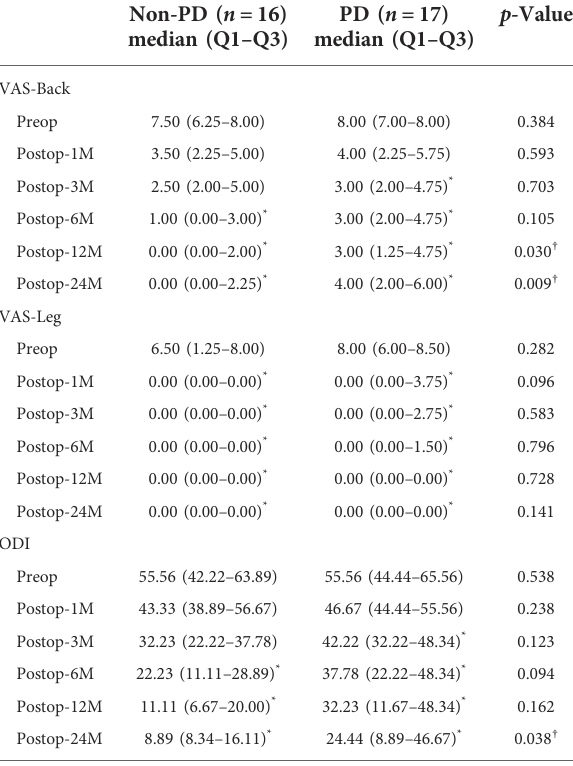
TABLE 2 Comparison of the clinical outcomes between the Non-PD and PD groups.